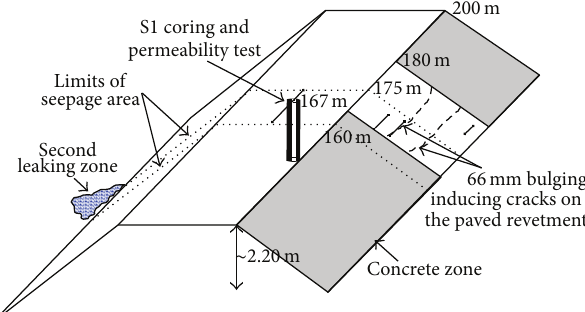
Figure 15: Sketch of the reported anomaly for the second leakage area(S1coringandpermeabilitytestingsat167 m;seealsoFigure